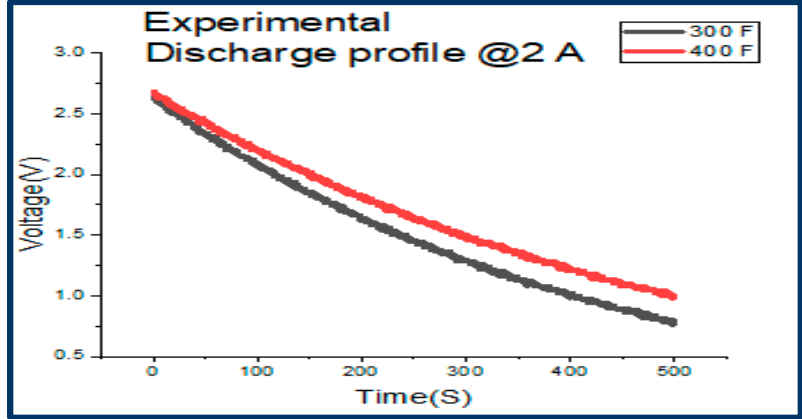
Figure 7. Experimental 300 F and 400 F discharge profile. As expected, the 300 F EDLC discharges at a faster rate than the 400 F, which is shown by the gradient being higher. The data from the discharge profile were used to calculate the ESR and the capacitance for the respective EDLCs, the results of which are shown in Table